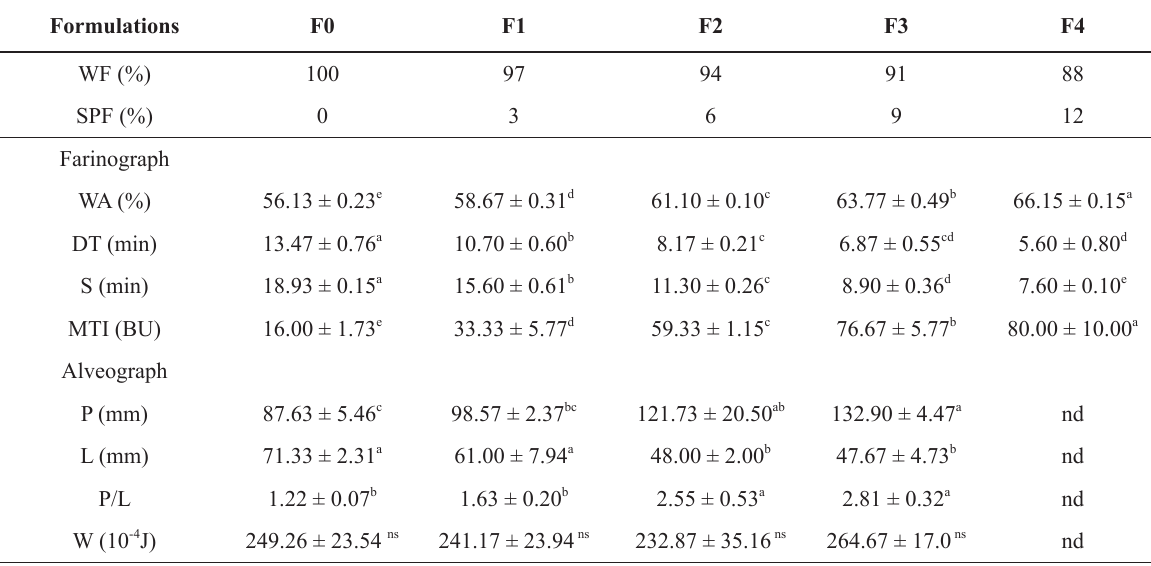
Farinograph and alveograph rheological parameters of blends of refined wheat flour and yellow sweet potato flour*.